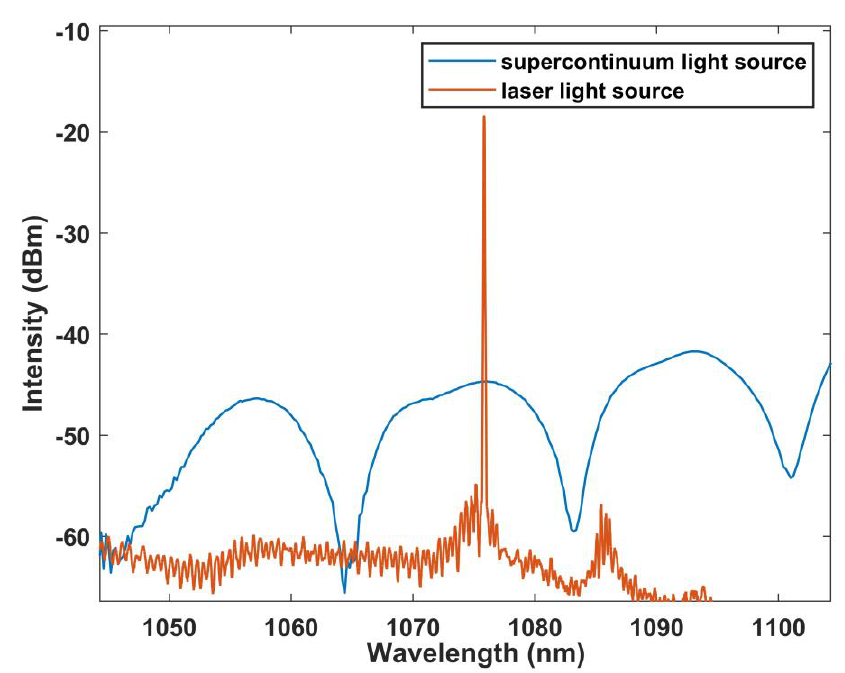
Figure 8. Corresponding curve of the output laser spectrum and interference spectrum.